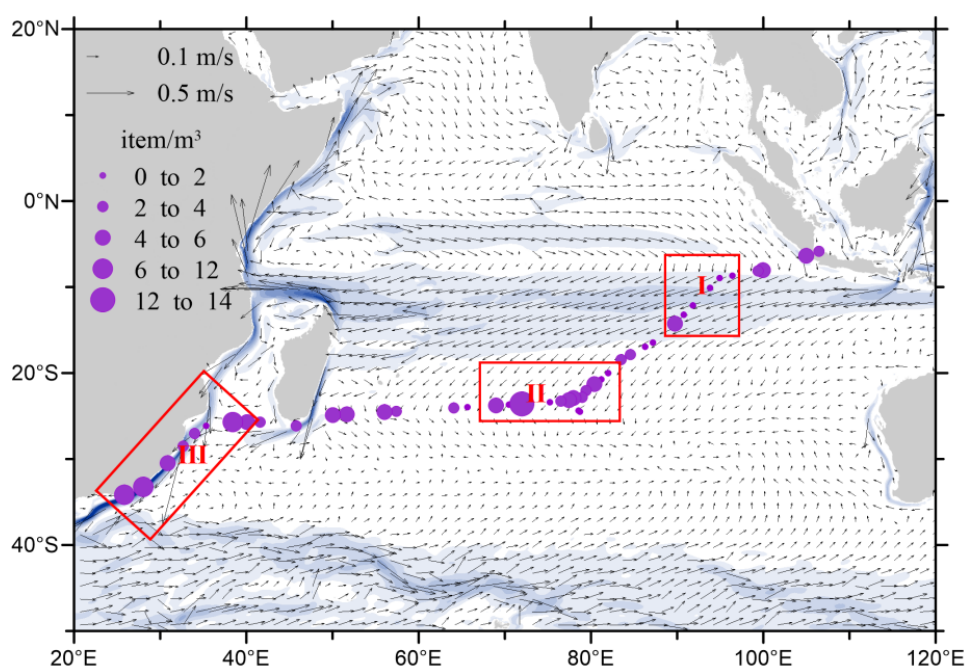
Figure 7. Upper-layer ocean circulation and microplastic distribution in the Indian Ocean. (I, II and III are the different specific area)